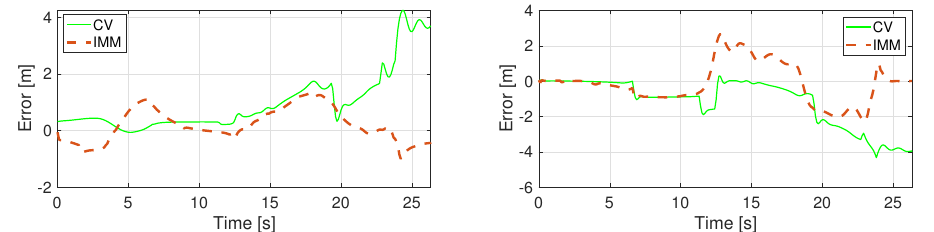
Figure 5. Position error in direction X ( left ) and Y ( right ) using the CV model.